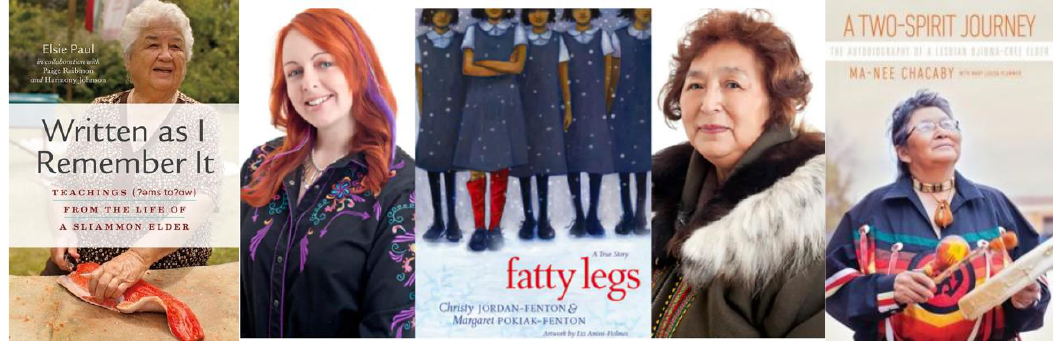
Figure 6 : Far left book cover for Elsie Paul’s book and far right another book by Indigenous authors Mary Louisa Plummer and Ma-Nee Chacaby (Strong Nations Publishing 2021). In the middle, photos published on the tenth anniversary of Jordan-Fenton and Pokiak- Fenton’s book release of Fatty Legs (Canadian Broadcasting Corporation 2021). Pokiak-Fenton has since passed